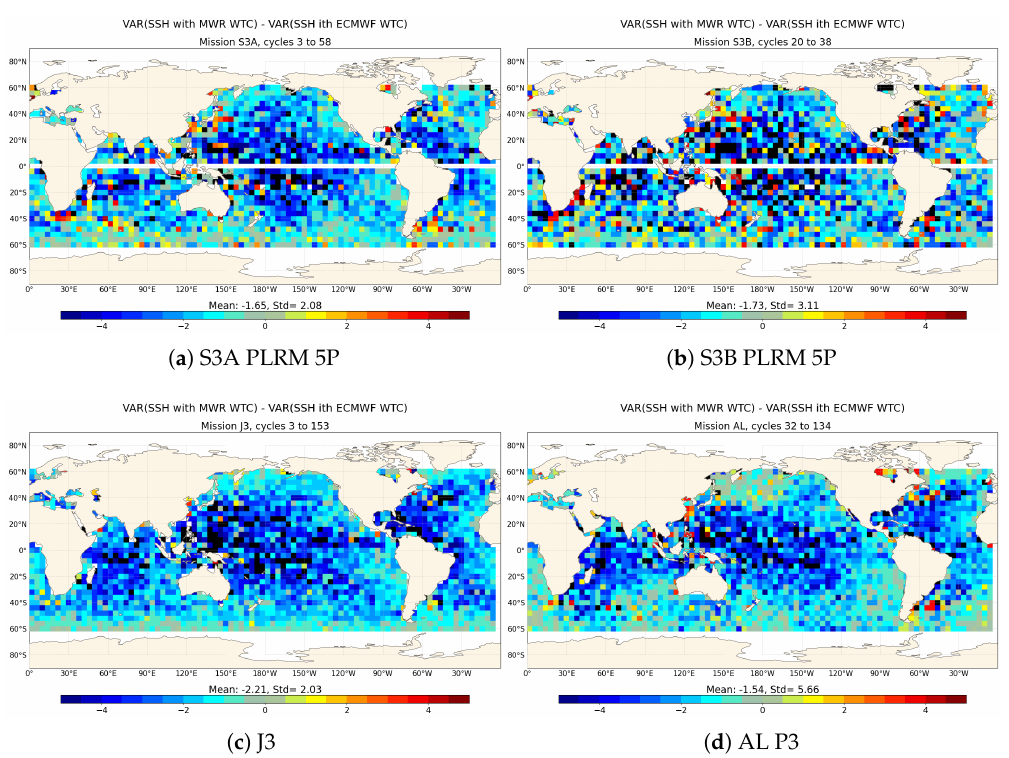
Figure 17. Performances of MWR solutions with respect to ECMWF. S3A, Jason-3 and AltiKa data cover a similar period of time of 4 years, S3B data cover only 1.5